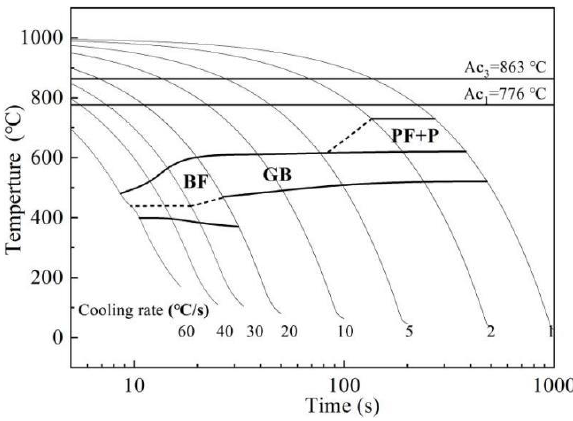
Figure 2. Continuous cooling transformation diagram of seamless pipe steel.